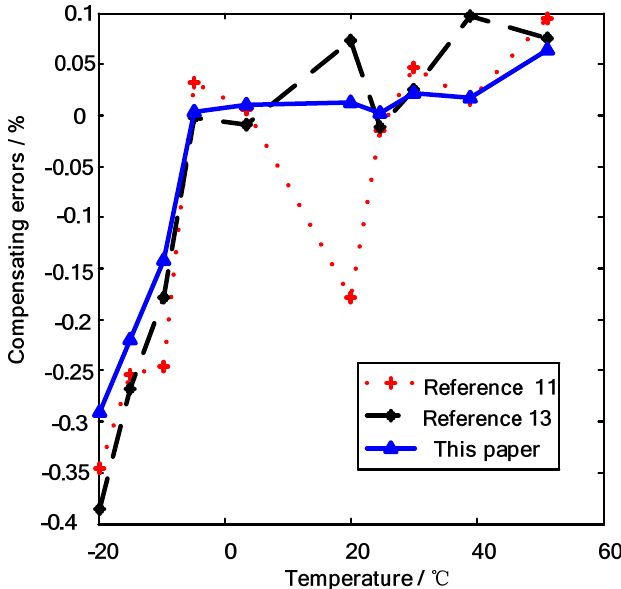
Figure 11. Error curve after compensation by three methods.